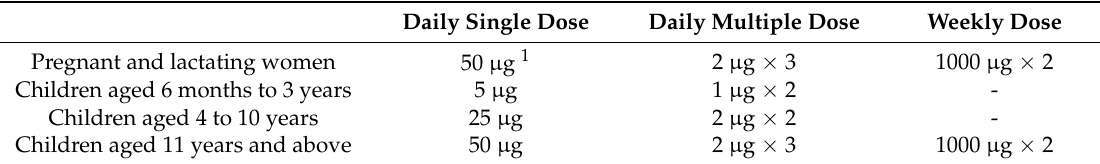
Table 2. Recommended vitamin B12 supplements for maintaining already normal B12 levels in pregnant and lactating women, infants, and children. Daily Single Dose Daily Multiple Dose Weekly Dose Pregnant and lactating